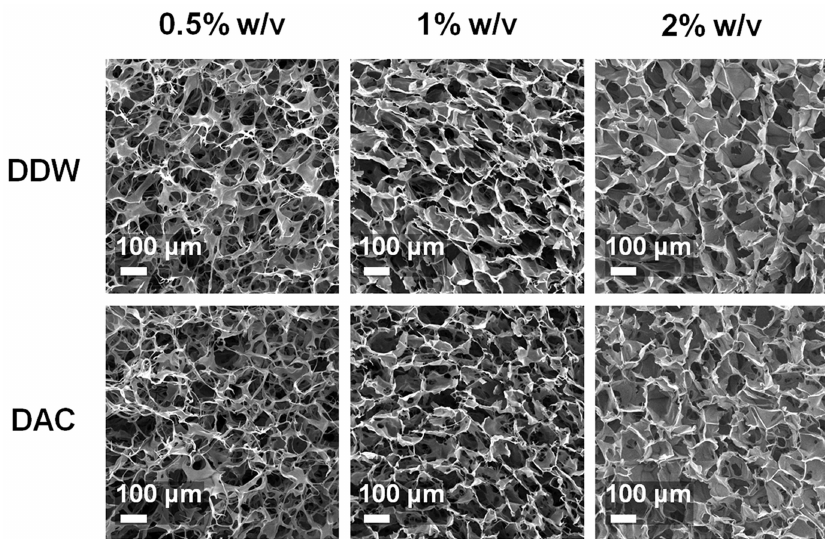
Figure 5. Morphological characteristics of porous scaffolds. Scanning electron micrographs represent the pore morphology of the top surface of the scaffolds.